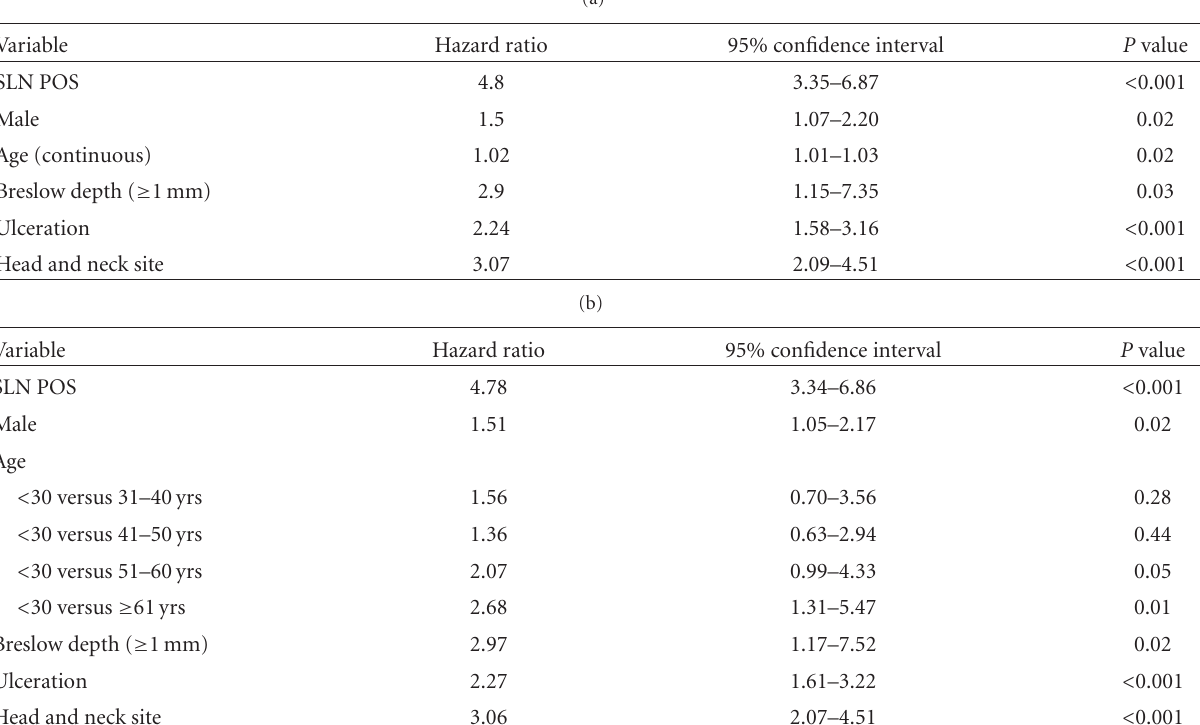
Table 2: Multivariable analysis of overall survival, using age by continuous variable and by